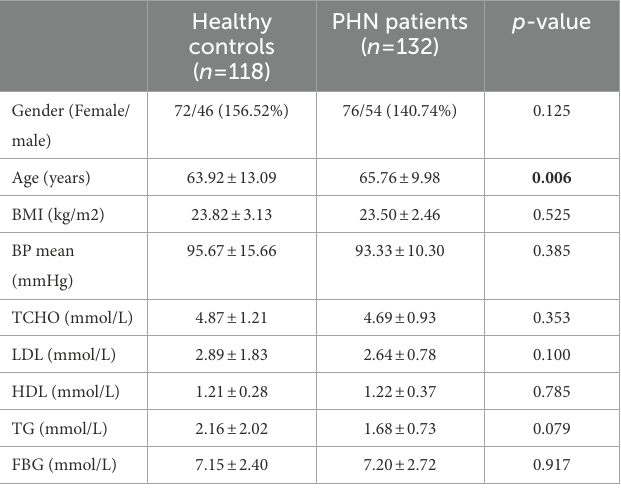
TABLE 1 Basic information of subjects.